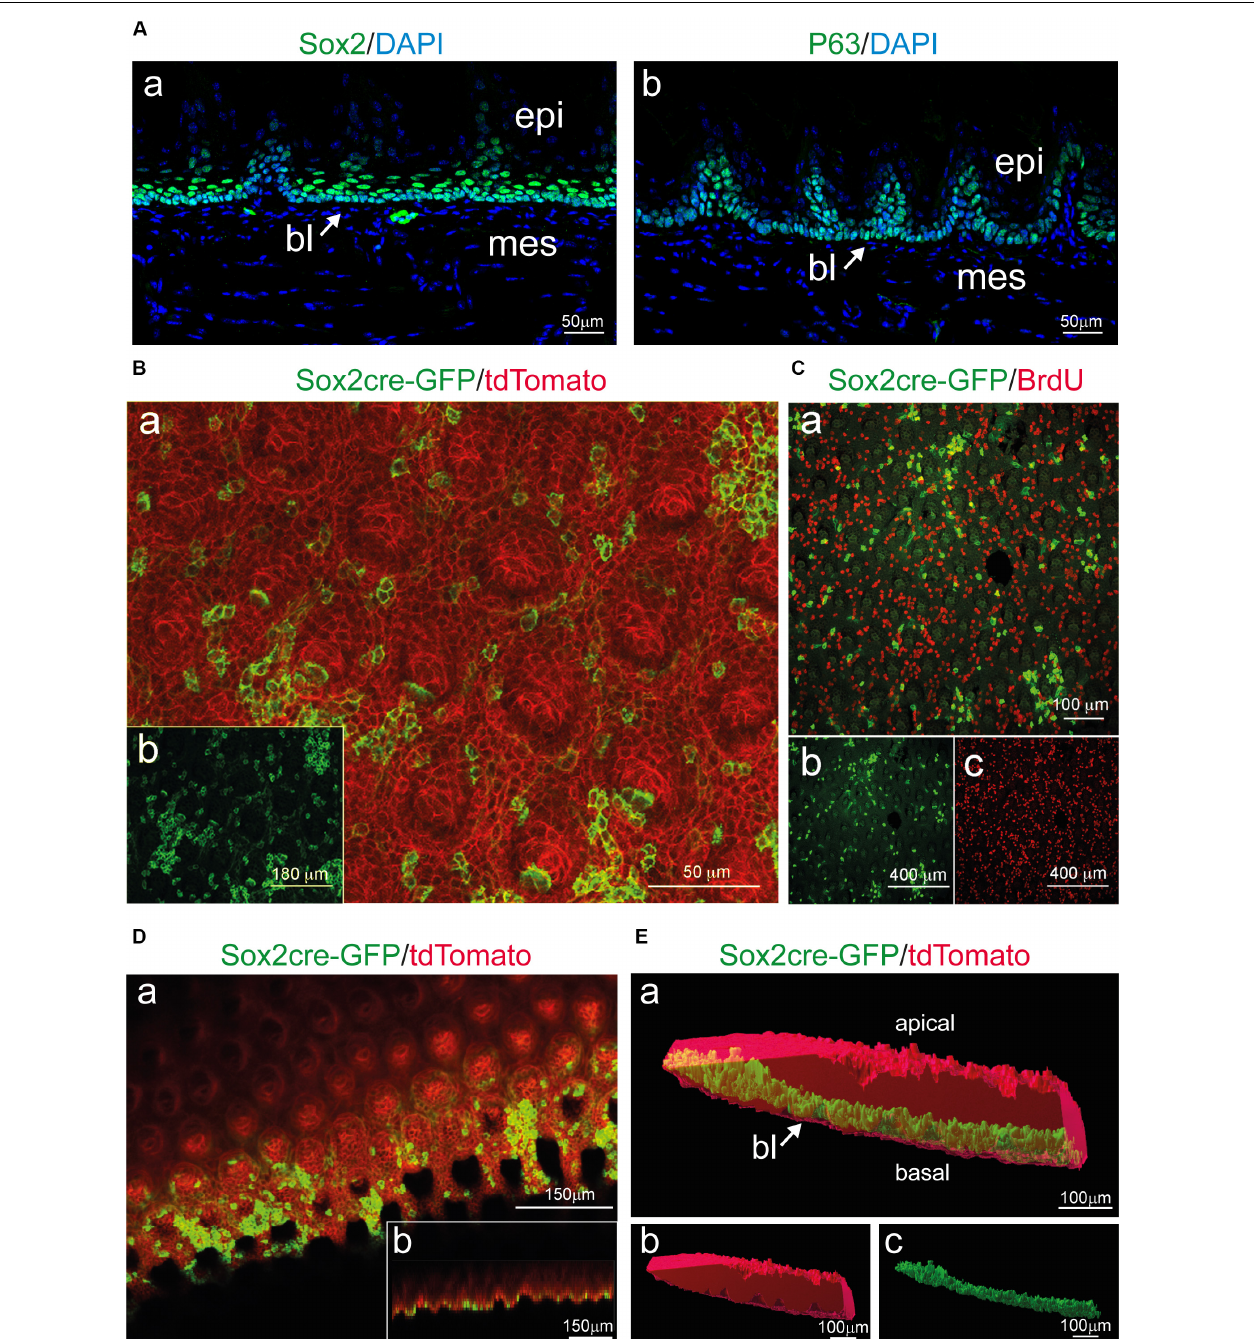
FIGURE 3 | Sox2 expression in the basal layer and whole mount imaging of tongue epithelial explants from induced Sox2 CreER ; R26 mT / mG mice. (A) Cross-section of the tongue stained for (a) Sox2 and (b) P63 identify progenitor cells in the basal layer (bl) of the epithelium (epi). Mesenchyme (mes) appears negative for both stainings. Arrows indicate the basal epithelial layer. (B) (a) Whole mount immunofluorescent staining for Sox2cre-GFP (green) and tdTomato (red) of the isolated tongue epithelium. (b) Single-channel image showing Sox2cre-GFP immunofluorescent staining (green color). (C) (a) Whole mount immunofluorescent staining for Sox2cre-GFP (green) and BrdU (red) of the isolated tongue epithelium. (b) Single-channel image showing Sox2cre-GFP immunofluorescent staining. (c) Single-channel image showing BrdU immunofluorescent staining. (D) (a) Whole mount immunofluorescent staining for Sox2cre-GFP (green) and tdTomato (red) of the isolated tongue epithelium displaying x-y orientation of the tissue. (b) Lower panel shows projection of the z-x axis (E) (a) 3D surface rendering of isolated epithelial tissue (red) with surface rendering displaying Sox2 + cells (green) in the basal layer of the isolated tissue. Arrow indicates the basal epithelial layer. (b) Single channel 3D surface rendering (red) of isolated epithelial tissue. (c) Single channel 3D rendering displaying Sox2 + cells (green) in the basal layer of the isolated tissue. bl, basal layer; epi, epithelium; mes, mesenchyme. Scale bars: Aa, Ab: 50 µ m; Ba: 50 µ m; Bb: 180 µ m; Ca: 100 µ m; Cb, Cc: 400 µ m; Da, Db: 150 µ m; Ea, Eb, Ec: 100 µ m.